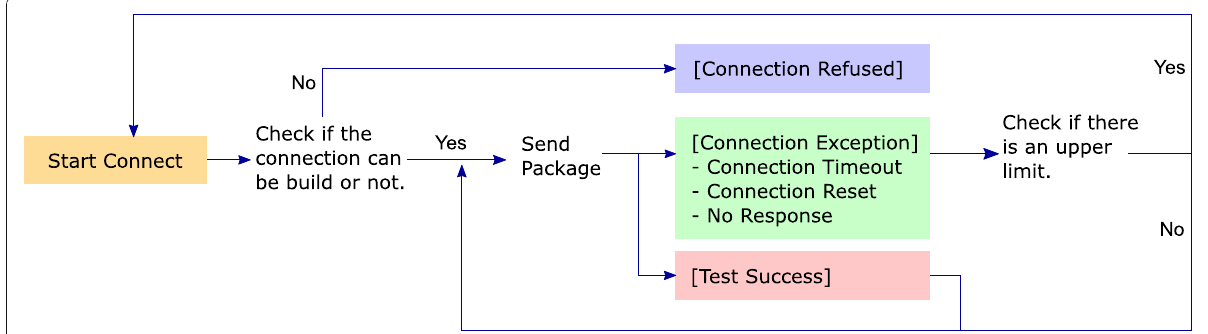
Fig. 10 The connection statuses. After sending the test data, the system will perform different processes according to the different response statuses of the